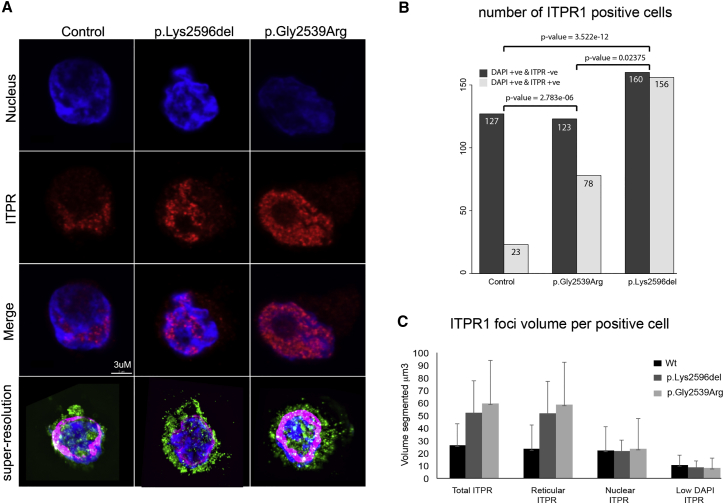
Functional Characterization of ITPR1/Itpr1 Mutations(A) Confocal imaging of lymphoblastoid cell lines (LCLs) showing representative examples from unaffected individuals (control 1 as an exemplar) or individuals with Gillespie syndrome (291_291 and 2018_2018 as exemplars). The top panel shows DAPI-stained nuclei. The panel below shows the punctate staining in the nuclear and perinuclear regions on immunofluorescence staining using an anti-ITPR1 antibody. ITPR1 mutant cells consistently showed more punctate staining within the nucleus compared to the controls. The third panel shows the merge of the first and second. The fourth panel shows super-resolution SIM imaging of representative LCL nuclei from each of the genotypes,(B) The number of ITPR1-stain-positive cells in LCLs with or without mutations in ITPR1 were analyzed with ImageJ. Area, shape descriptor, and mean gray value were measured for each cell. In control LCLs, <20% of the DAPI-positive (+ve) cells were also +ve for ITPR1 immunofluorescence. In cells carrying either of the indicated mutations, 30%–50% of the cells were ITPR1 positive. Chi-squared tests of the difference between the mutant and control cells suggest these are very unlikely to be chance observations.(C) Quantitative fluorescence analysis from 3D super-resolution images showing the mean total volume of ITPR1-positive foci for the following compartments within the cell: whole cell, reticular component, whole nucleus, and low-DAPI regions of the nucleus. Multiple individual cells from two independent LCLs derived from affected individuals per genotype were obtained via structured illumination microscopy (SIM). The masking strategy used to obtain these data is outlined in Figure S3. The error bars in this graph represent standard error of the mean. No significant difference was observed between genotypes.